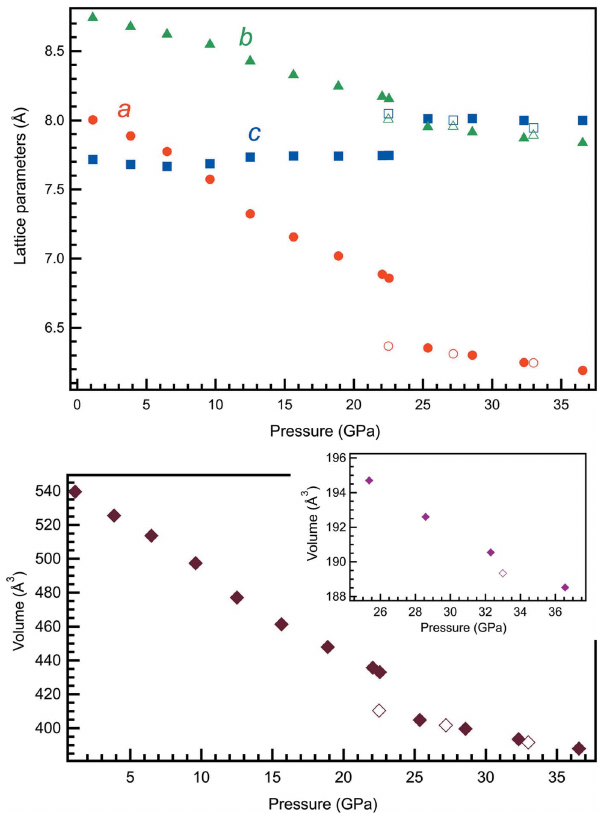
Figure 2 The evolution of the unit-cell parameters of danburite along the compression. The inset shows the dependence of the volume of the P 1 phase (danburite-III) on the pressure increase. Filled and open symbols correspond to experiments 1 and 2, respectively. The errors are smaller than the size of the symbols.